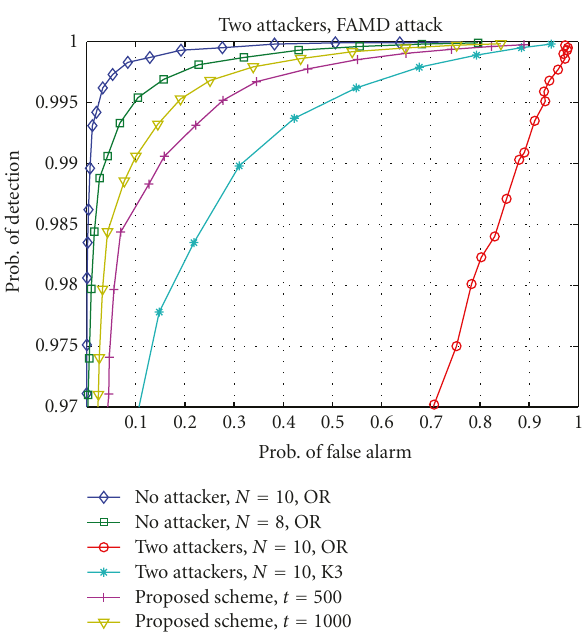
Figure 5: ROC curves for di ff erent collaborative sensing schemes ( P a = 50%, False Alarm & Miss Detection Attack).